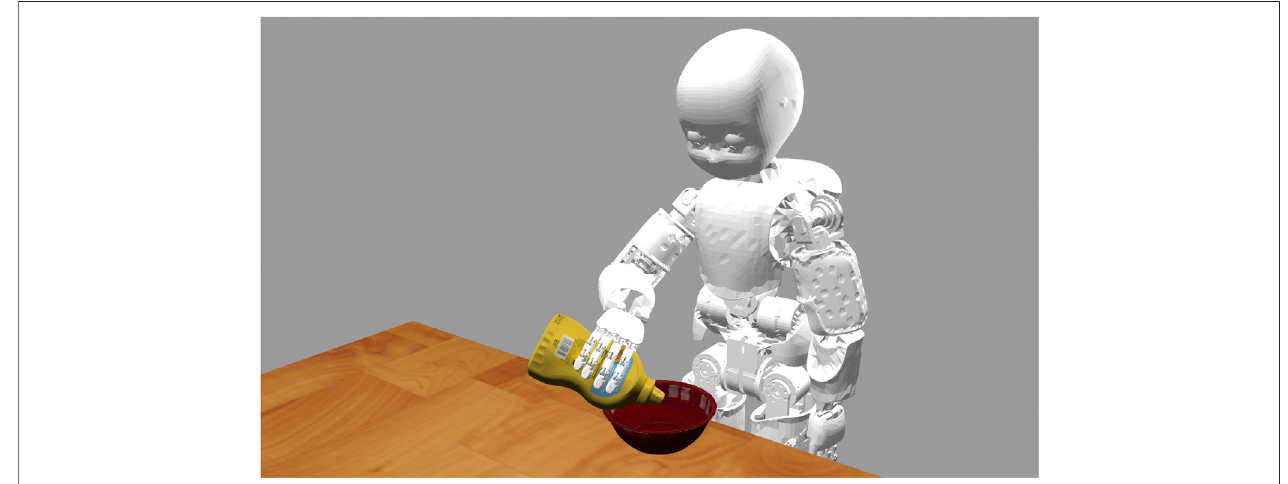
FIGURE 5 | The iCub robot in the Gazebo environment.